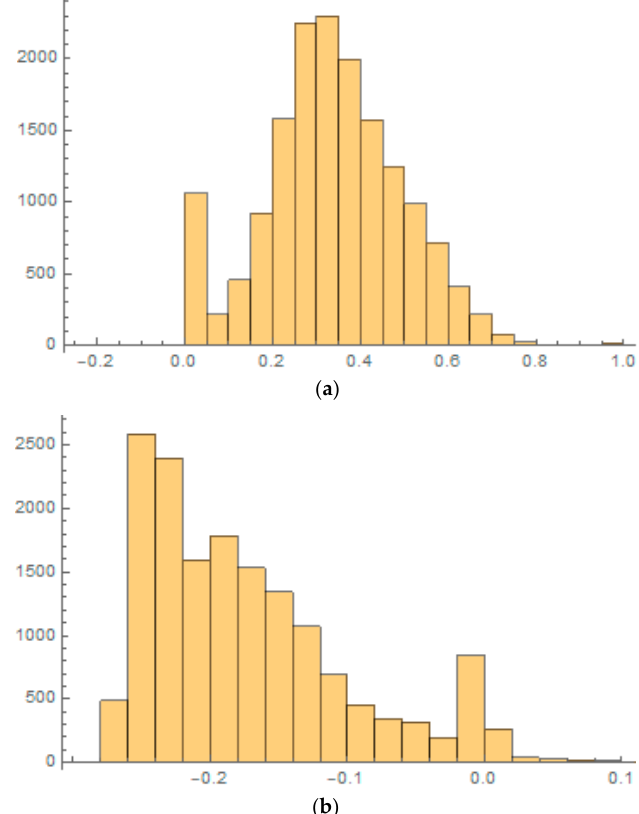
Figure 1. Histograms for the level and the slope of market-implied recovery rates. Panel ( a ) shows the distribution of the level (10-year recovery rate). Panel ( b ) shows the distribution of the slope (10-year rate minus five-year rate). The sample contains 16,062 quarterly observations and it spans the January 2005–June 2014 period.